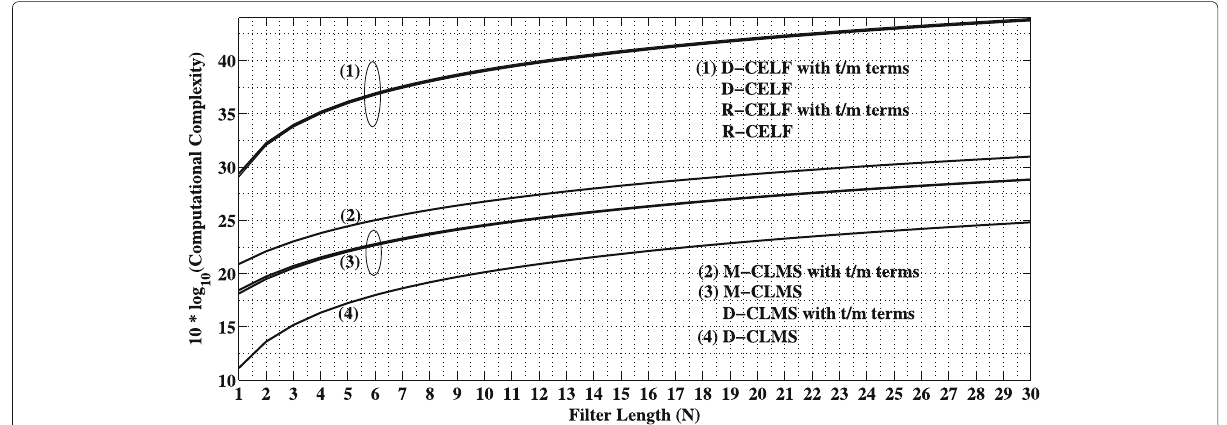
Fig. 8 Computational complexity comparison for M =